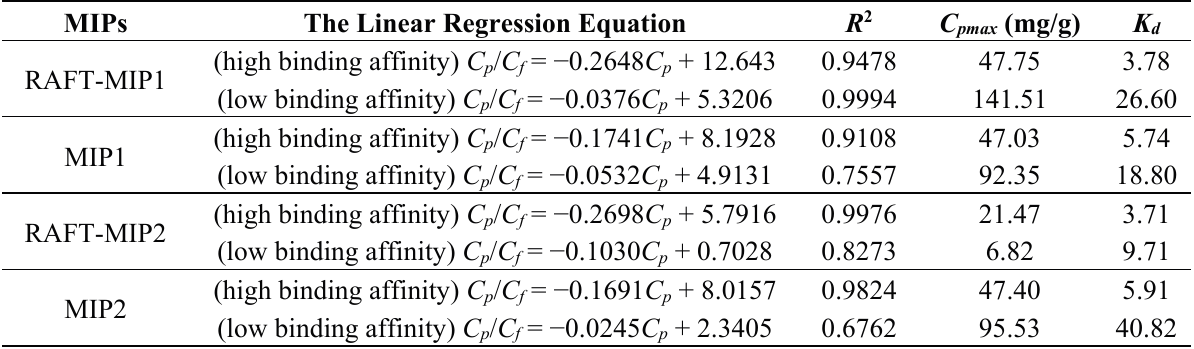
Table 4. The apparent maximum number, C pmax and the equilibrium dissociation constant, K d